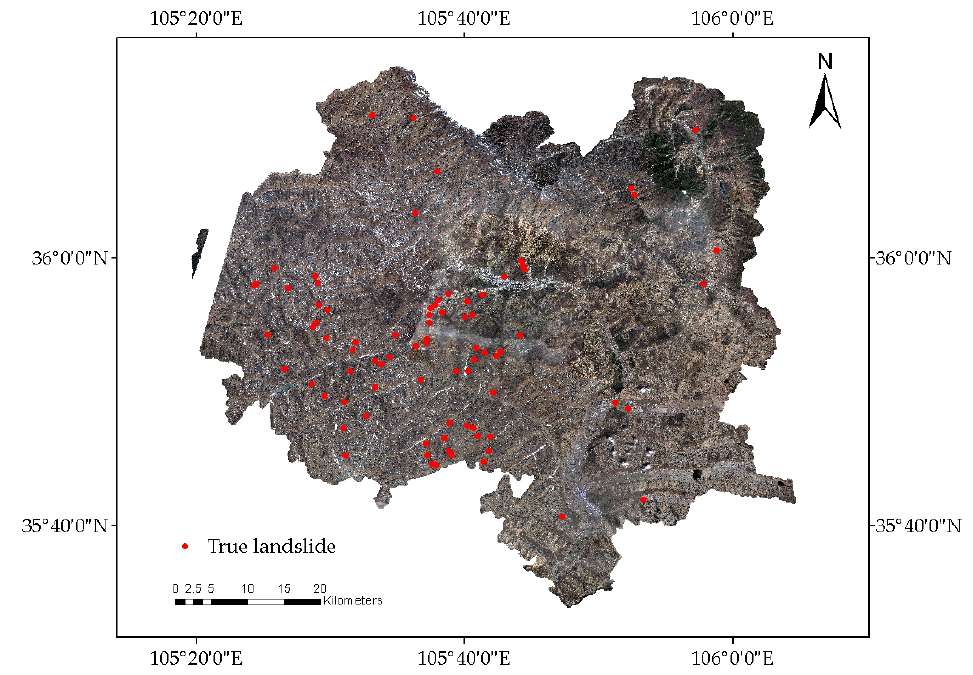
Figure 9. Information of the Study Area: Xiji